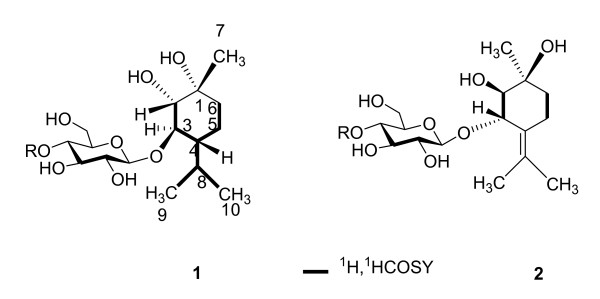
rel-(1R,2S,3R,4R)p-menthane-1,2,3-triol
3-O-β-D-glucopyranoside (1)
andrel-(1S,2R,3S) terpinolene-1,2,3-triol
3-O-β-D-glucopyranoside (2) from mentha haplocalyx Briq.